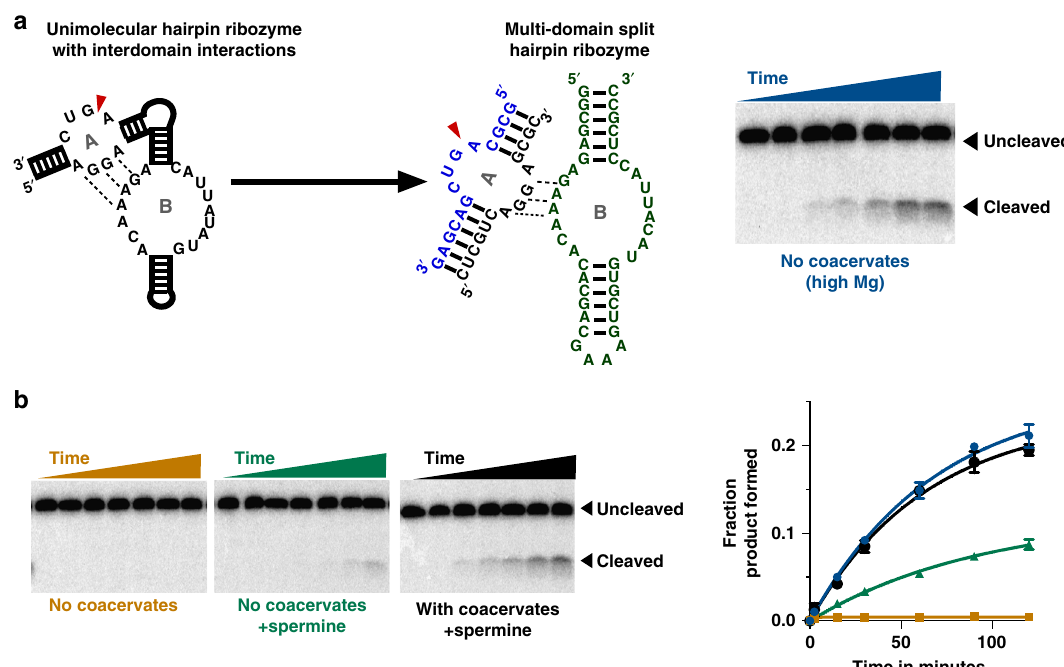
Fig. 6 Concentration of cofactors in coacervates enhances of hairpin ribozyme catalysis. a Consensus secondary structure of the unimolecular hairpin ribozyme with conserved nucleotides (left), the site for cleavage is indicated with red arrowhead. Multi-domain split hairpin ribozyme where loop A consists of the substrate (blue) and the substrate-binding strand (black) and loop B domains separated (green). Gel image showing cleavage of the substrate is shown. Reaction were performed in buffer containing 25 mM Tris – HCl pH 7.5, 25 mM MgCl 2 and 25 mM KCl. Reactions contained 1 nM substrate, 1 µ M substrate-binding strand, and 1 µ M of the loop B domain. b Substrate cleavage of loop A domain by the ribozyme at sub-optimal conditions. All reactions were performed in 25 mM Tris·HCl pH 7.5, 2.5 mM MgCl 2 , and 2.5 mM KCl with additional components as indicated. Reactions contained 1 nM substrate, 50 nM substrate-binding strand, and 25 nM of the loop B domain. Coacervates were formed by PDAC-53 and spermine at 5 mM total positive charge from each and 10 mM total negative charge from polyaspartic acid (D 30 ). Time points were taken at 0, 2.5, 15, 30, 60, 90, and 120 min. Plots showing fraction product cleaved versus time is shown in right. Fractions product formed were fi t to Eq. (1). Colors in the plot correspond to labels of gel images. All error bars represent S.E.M. ( n = 3) from three independent experiments. Uncropped gel images are shown in Supplementary Figure